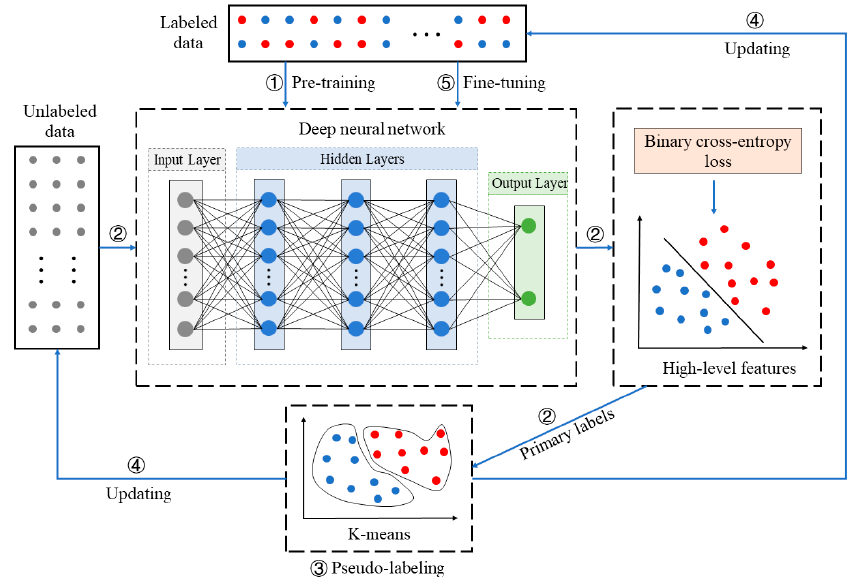
Figure 6. Framework of semi-supervised learning.